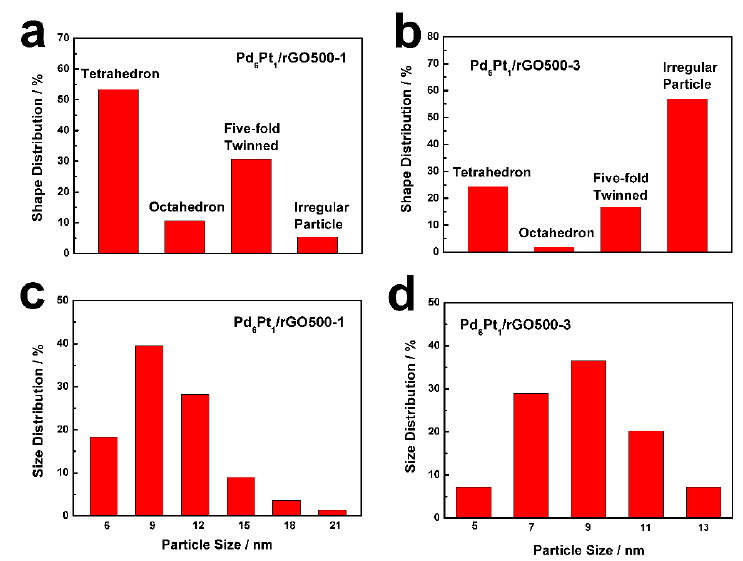
Figure 3. Shape distributions ( a , b ) and size distributions ( c , d ) of polyhedral Pd 6 Pt 1 nanocrystals on Pd 6 Pt 1 / rGO500-1 ( a , c ) and Pd 6 Pt 1 / rGO500-3 ( b , d ) Pd 6 Pt 1 /rGO500-1 (a,c) and Pd 6 Pt 1 /rGO500-3 (b,d) substrates.